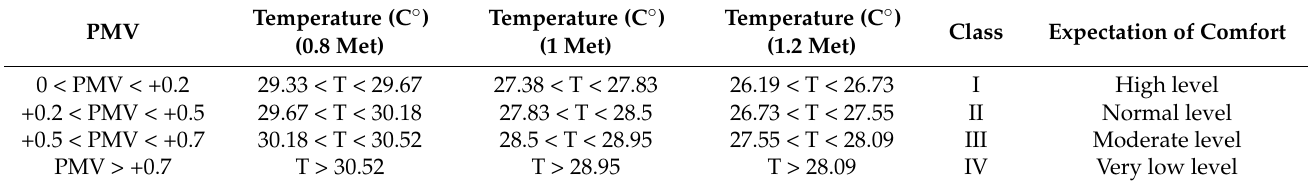
Table 4. PMV Class and expected comfort for an air velocity of 0.1